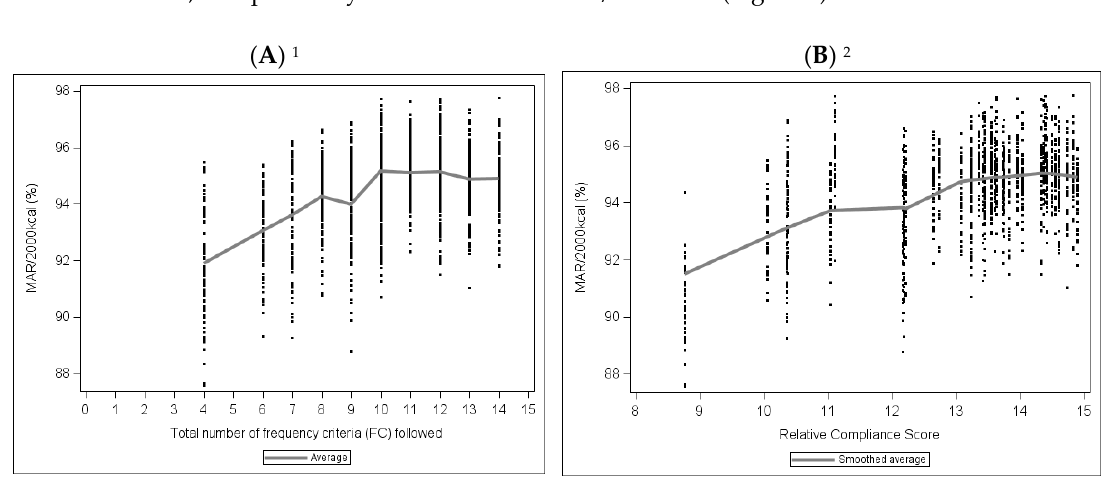
Figure 3. Mean Adequacy Ratio (MAR, expressed in % of adequacy for 2000 kcal) point clouds according to the level of compliance with frequency criteria (FC) estimated by the “Number of FC Followed” ( A ) and the “Relative Compliance Score” ( B ) in the “Compliance with Observed Series” series ( n = 1600 series simulated by scenario 1, with recommended weights). 1 Spearman correlation: 0.36, p < 0.0001; 2 Spearman correlation: 0.34, p < 0.0001.